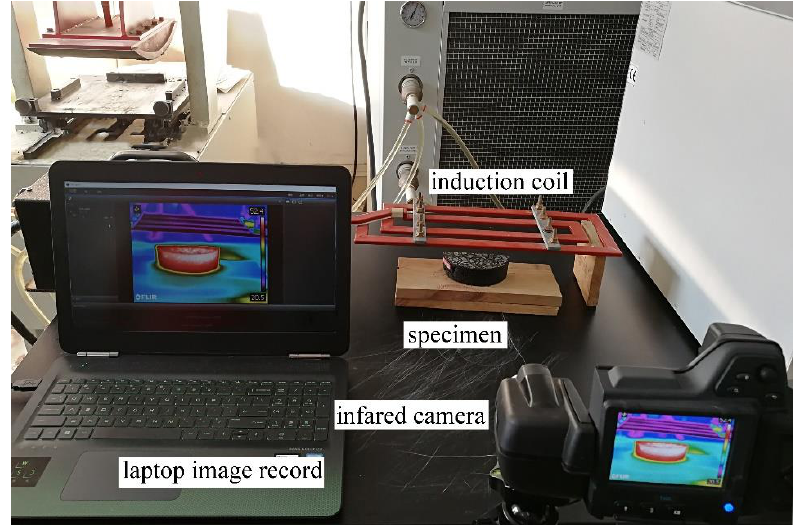
Figure 3. Heating and cooling testing system